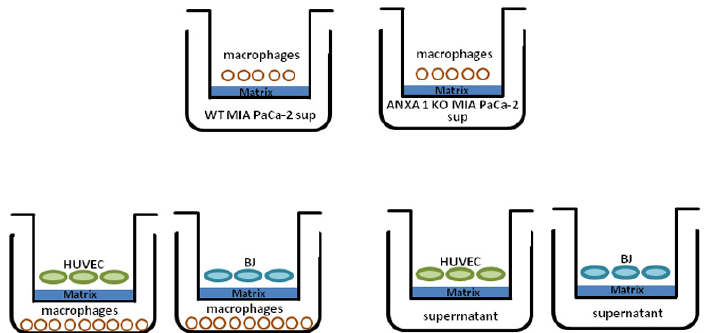
Figure 7. M&M: schematic representation of co-culture system.